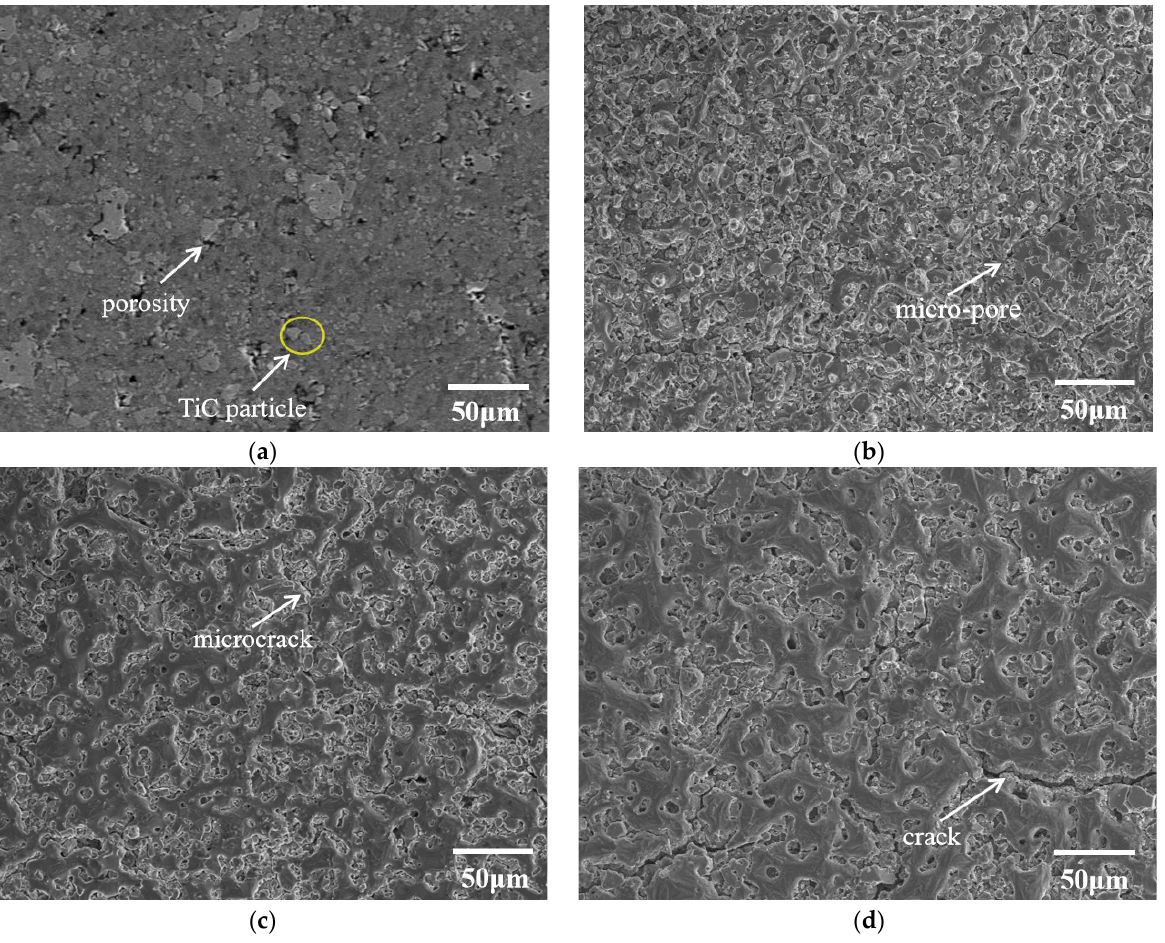
Figure 3. SEM images of Al-20TiC composites before and after HCPEB treatment: ( a ) initial sample; ( b ) 5-pulse-treated sample; ( c ) 15-pulse-treated sample; ( d ) 25-pulse-treated